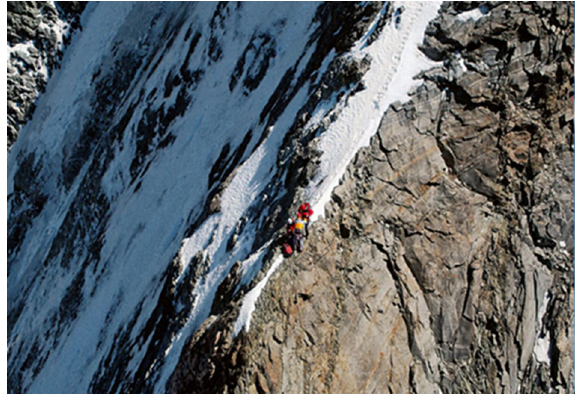
Figure 4. In almost 80 percent of the analyzed cases, alpinists were not injured when stranded, often on a classic route on a peak over 4000 m. A typical situation of being stranded is shown on the left on the Zmuttgrat on the Matterhorn. Alpinists overestimated their abilities and did not have enough time to return. A helicopter with longlines is then often the only possibility for